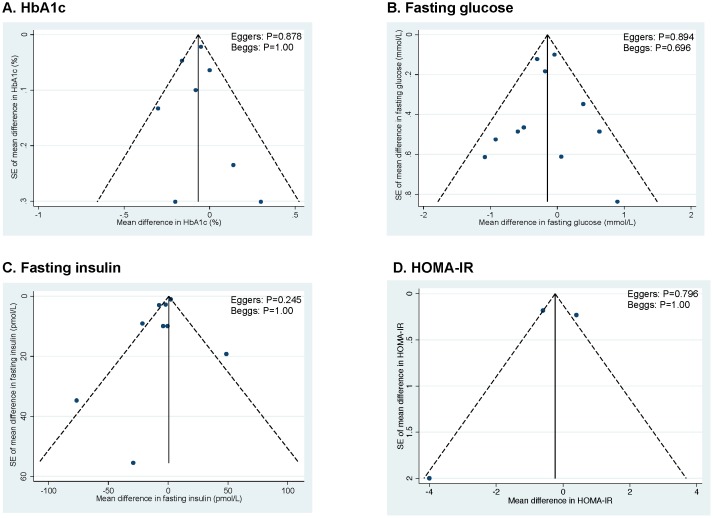
Publication bias funnel plots.Publication bias funnel plots for HbA1c (A), fasting glucose (B), fasting insulin (C), and HOMA-IR (D). The solid line represents the pooled effect estimate expressed as the weighted mean difference for each analysis. The dashed lines represent pseudo-95% confidence limits. P-values displayed in the top right corner of each funnel plot are derived from quantitative assessment of publication bias by Egger’s and Begg’s tests.